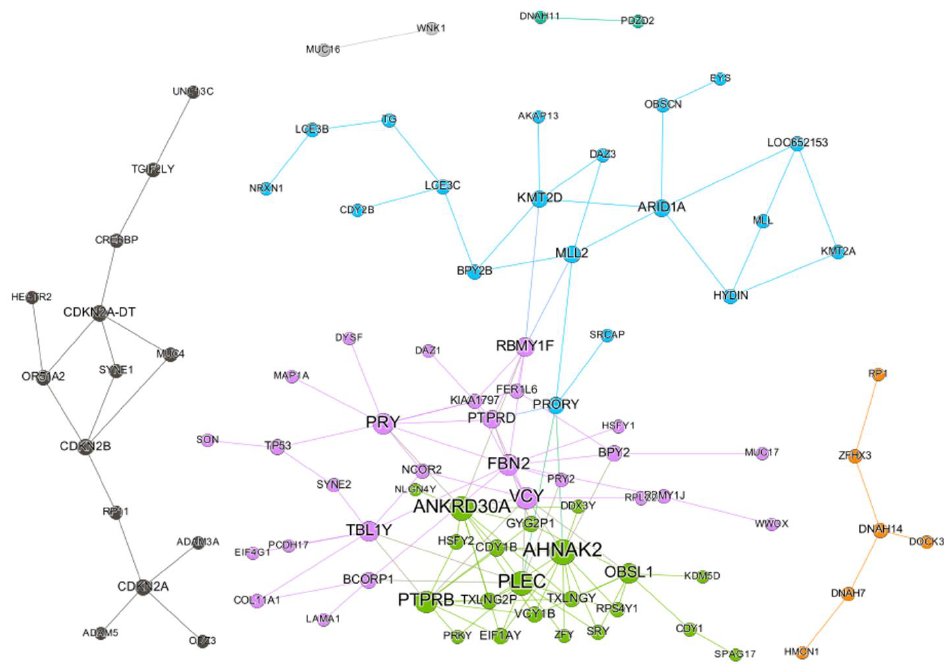
Figure 2. Inferred synthetic cytotoxic interaction network of